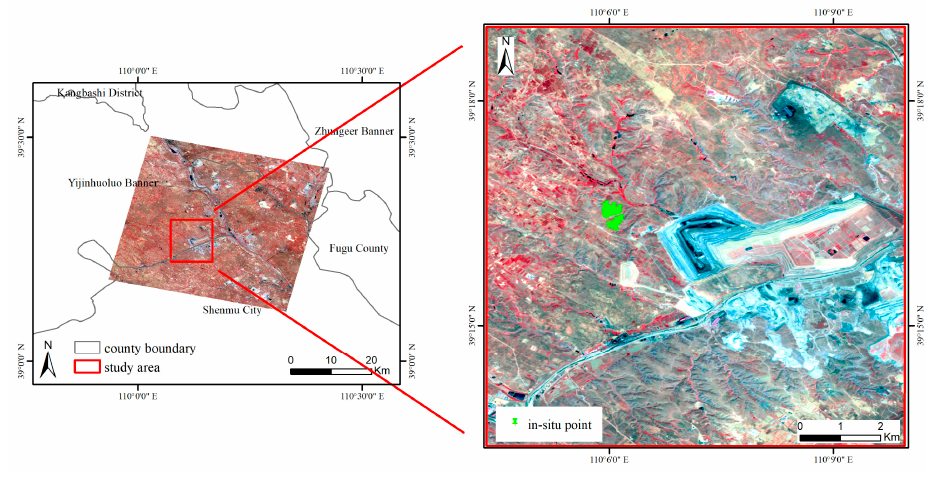
Figure 1. Location of the study